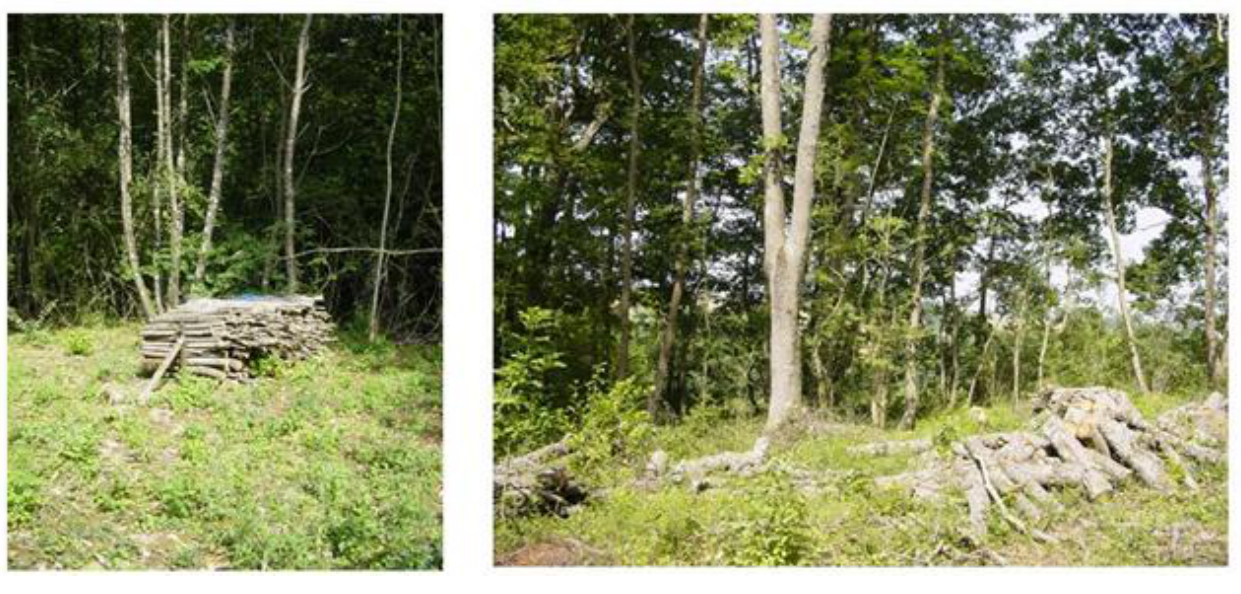
Fig. 3. Old and new practices. On the left, logging done by a retired farmer who had carefully cleared the ground of branches and piled the logs, even small ones, as was done in the past. On the right, logging done by a younger, active farmer, who had roughly piled the largest logs, in order to work more rapidly. This example illustrates that forestry practices are changing and may have new ecological consequences, with a greater quantity of organic matter probably being left on the ground in the latter case. The traditional chestnut coppice structure, with a few oak standard trees, can be seen in both pictures. On the right, the trees in the background are a narrow fringe purposefully left along the woodlot edge, illustrating that a specific management is often applied to edges. Credit: A.